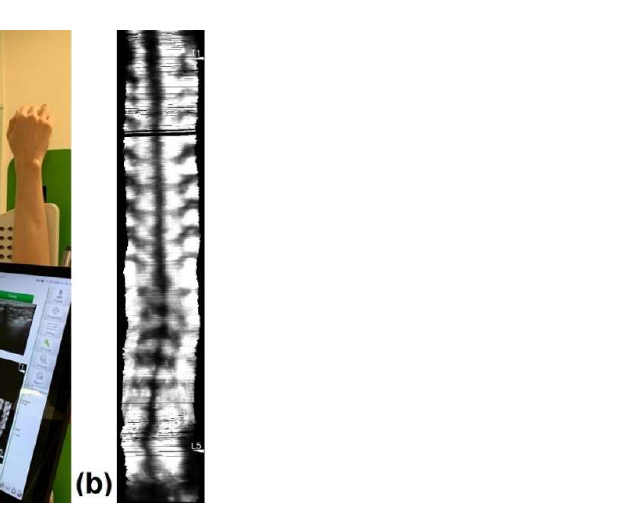
Figure 4. Assessment by portable 3D ultrasound imaging system Scolioscan Air: ( a ) subject being scanned and software interface shown during scanning and ( b ) typical resulting images of a scoliosis patient.